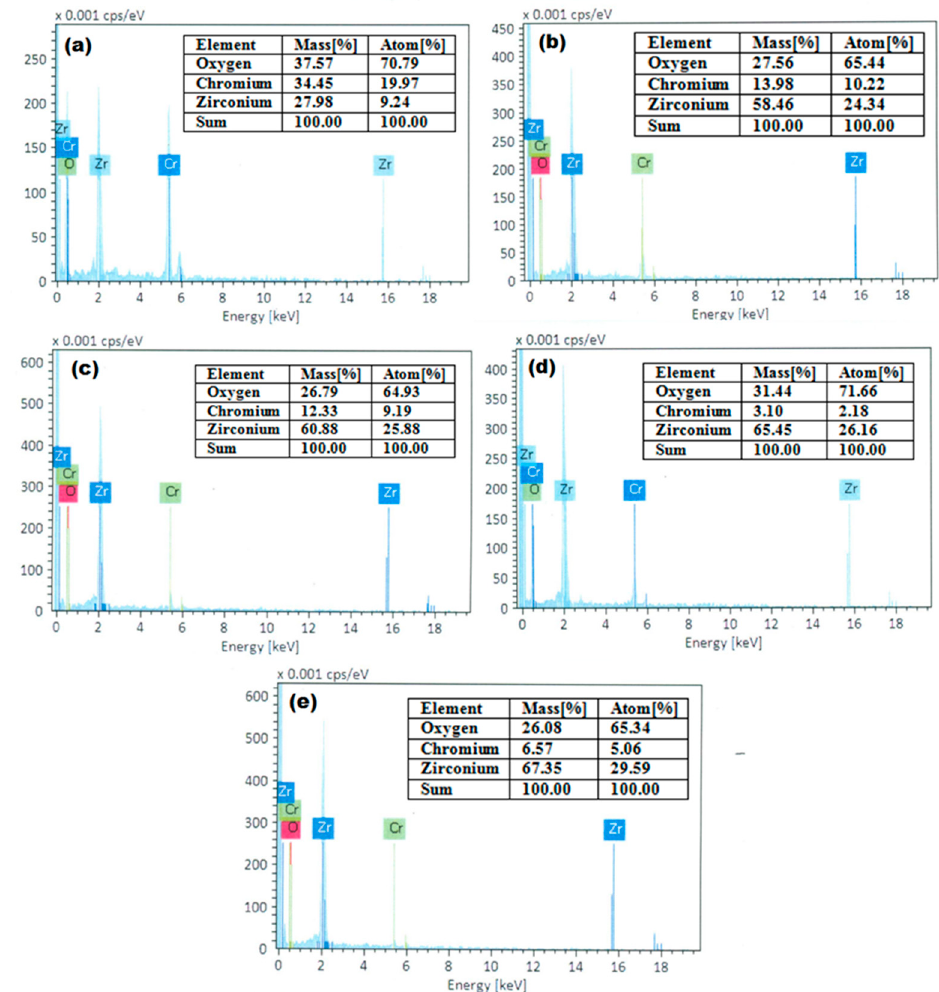
Figure 3. EDX spectra of ( a ) Zr1CrO 2 , ( b ) Zr3CrO 2 , ( c ) Zr5CrO 2 , ( d ) Zr7CrO 2 , and ( e ) Zr9CrO 2 photocatalysts. Catalysts 2021 , 11 , x FOR PEER REVIEW